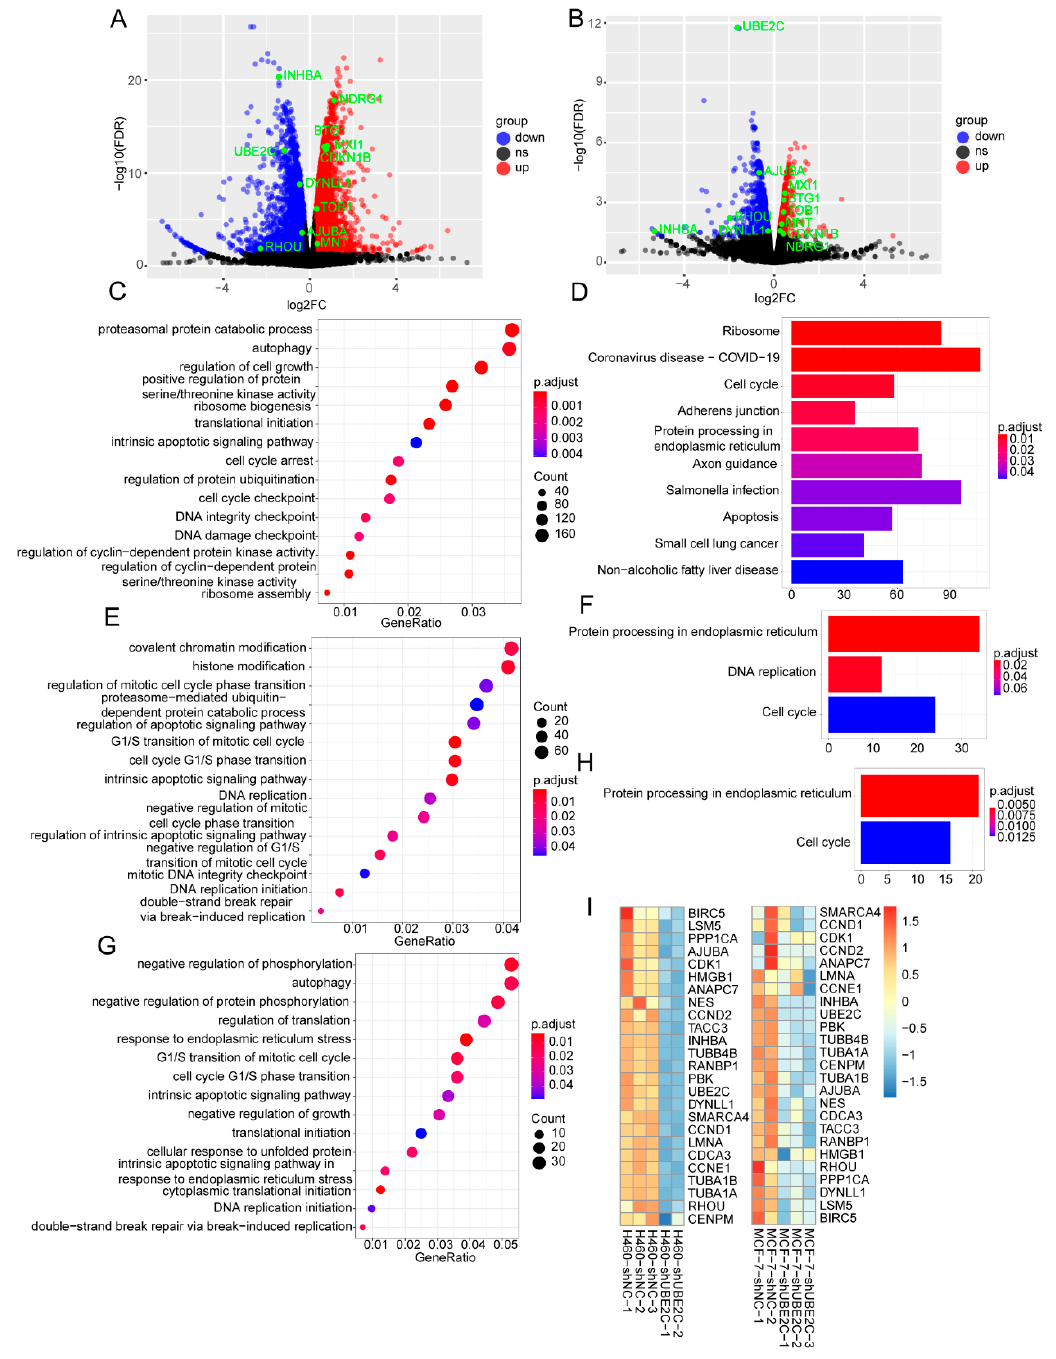
Figure 7. Functional enrichment analysis of RNA-Seq DEGs. ( A , B ) The volcano maps of NCI-H460 (left panel) and MCF-7 (right panel) DEGs with threshold of |FC| > 1.2 and FDR < 0.05. ns: no significance. ( C , D ) The GO_BP and KEGG pathways of NCI-H460 DEGs, respectively. ( E , F ) The GO_BP and KEGG pathways of MCF-7 DEGs, respectively. ( G , H ) The GO_BP and KEGG pathways of the overlap DEGs between NCI-H460 and MCF-7 cells, respectively. ( I ) The cell-cycle-related genes from both TCGA and RNA-seq were clustered using hierarchical clustering based on Euclidean distance. The color represents the TPM of different genes from shUBE2C and shNC groups of NCI-H460 and MCF-7 cancer cell lines.